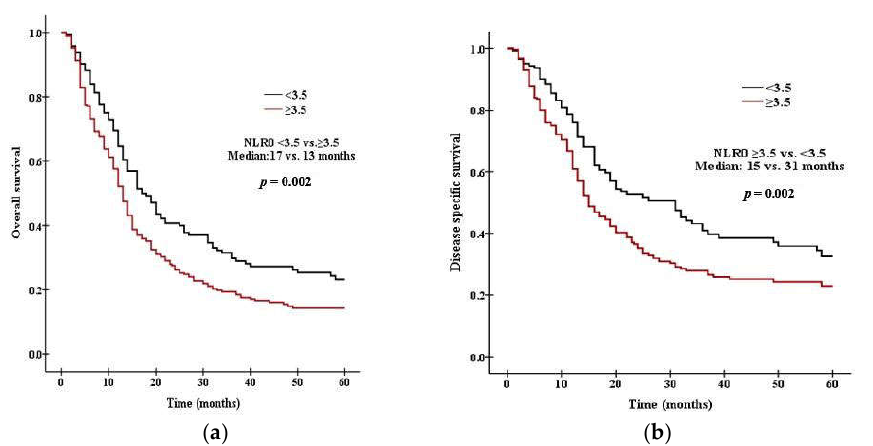
Figure 2. Kaplan–Meier curves of ( a ) OS in patients with NLR0 < 3.5 versus NLR0 ≥ 3.5, ( b ) DSS in patients with NLR0 < 3.5 versus NLR0 ≥ 3.5.